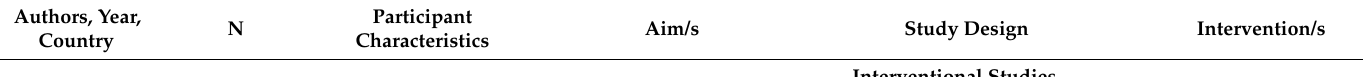
Table 1. Characteristics and outcomes of the selected